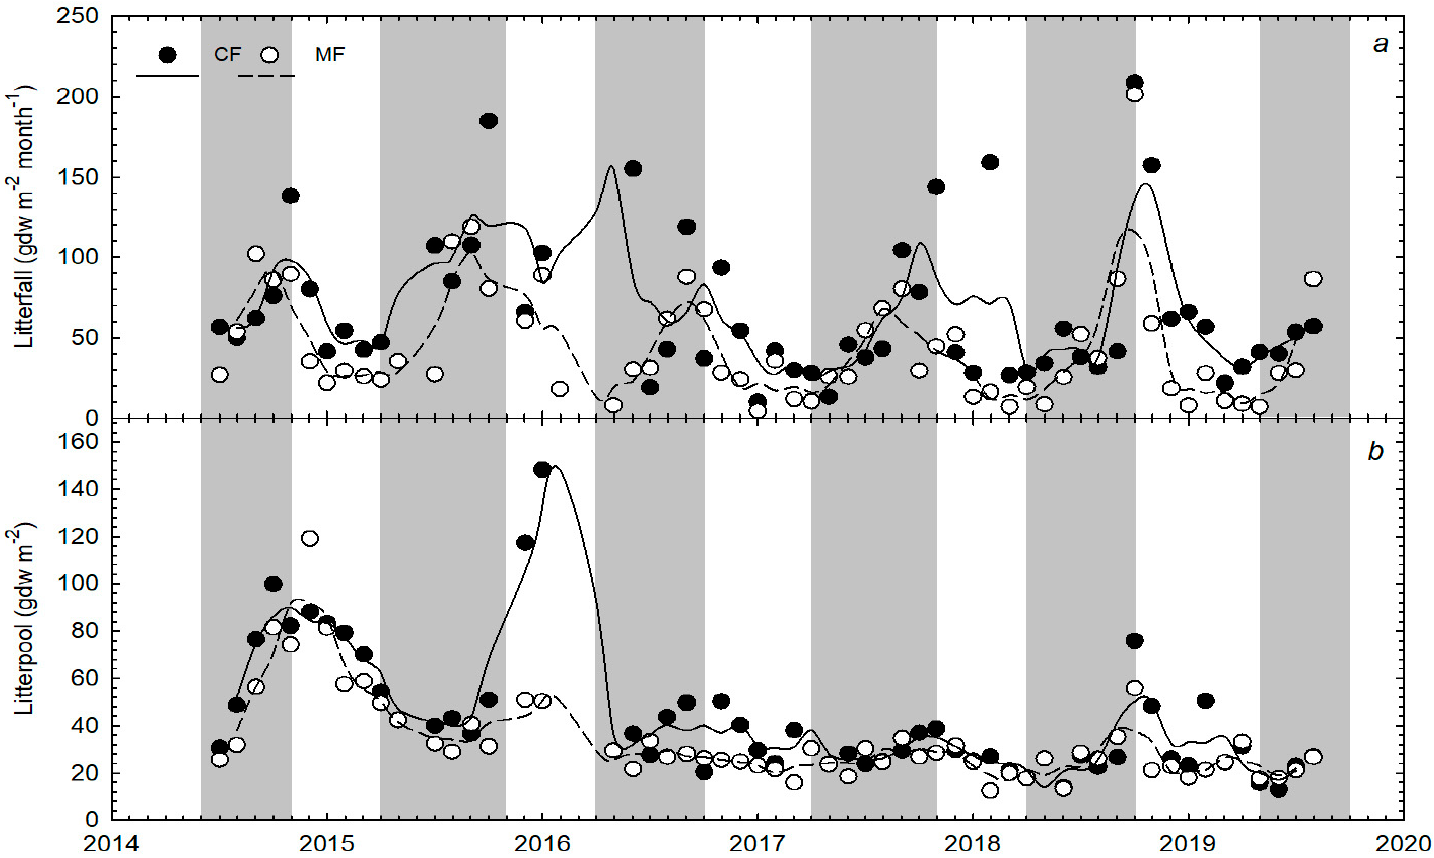
Figure 3. Mean monthly rate of total litterfall ( a ) and litter pool mass ( b ) presented as dry mass per unit area (gdw m − 2 ) for the seasonally flooded cerrado forest (CF: closed symbols) and the upland mixed forest (MF: open symbols) during the 2014–19 study period. The shaded areas depict the dry season (precipitation < 100 mm/month) and the solid and dashed lines depict a three-month running average for the cerrado and mixed forests, respectively.